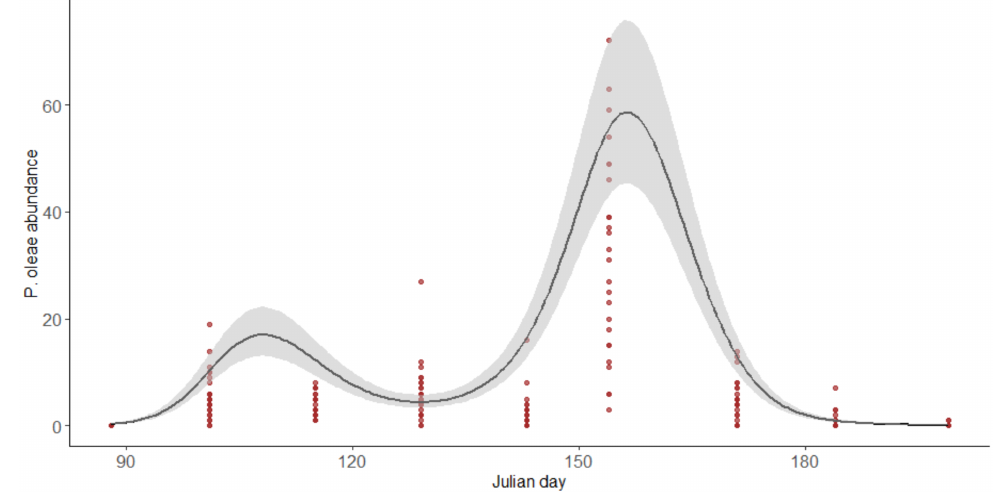
Figure 2. Abundance of P. oleae along time (in Julian days). Black solid line represents the predictions of the model for the abundance of P. oleae . Shaded areas represent the interval of confident at